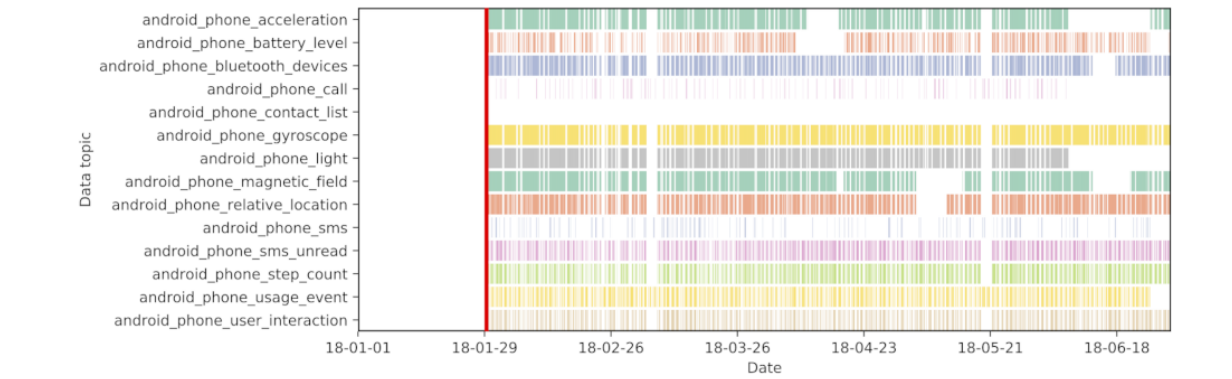
Figure 6. Contiguity of phone sensor data over 6 months collected through RADAR-base for aparticipant in the major depressive disorder study. The red line corresponds to the enrollment date, whereas a coloured segment on each row corresponds to recorded data at an hourly